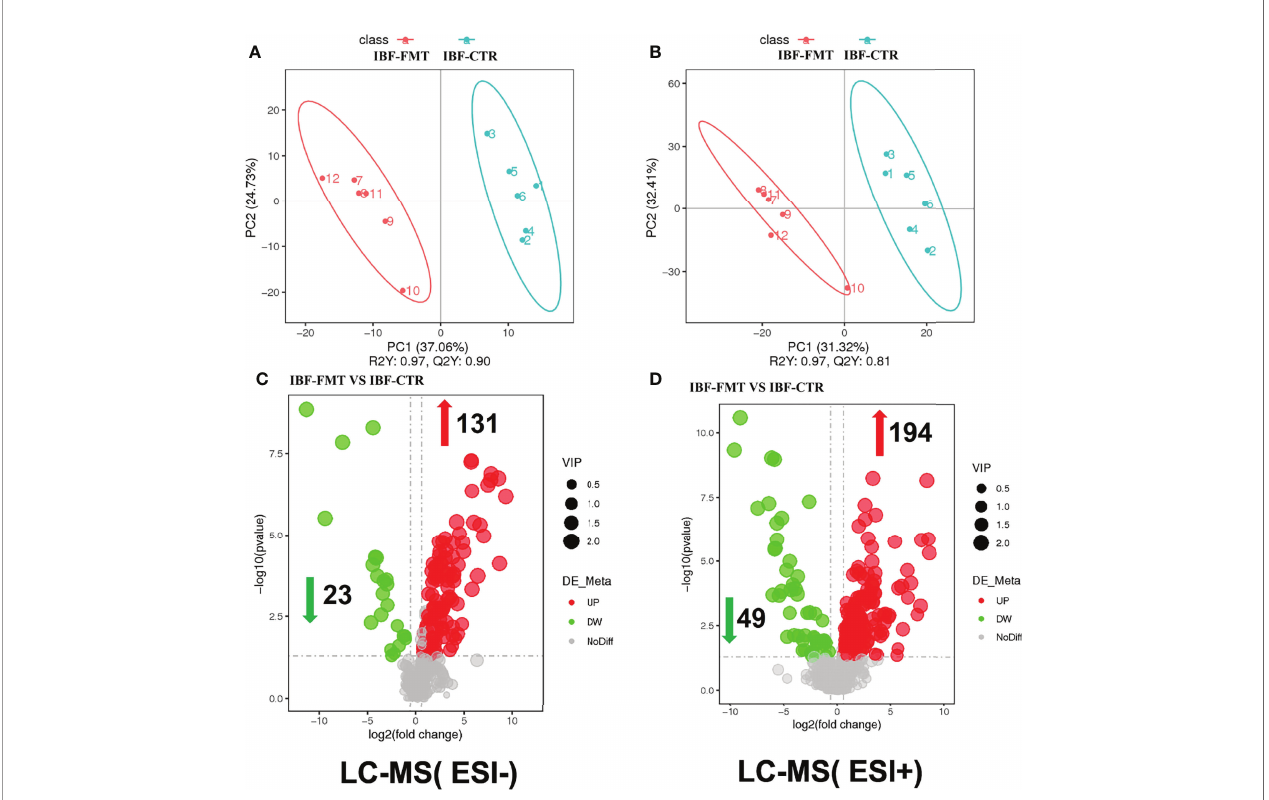
FIGURE 5 | Comparison of ileal chyme metabolome between the birds in IBF-CTR and IBF-FMT group. The analysis of panel (A) and panel (B) were based on the discriminant analysis of partial least squares (PLS-DA). The results in anion mode were showed in panel (A) and panel (C) , and the results of cation mode were arranged in panel (B) and panel (D) , n=6.